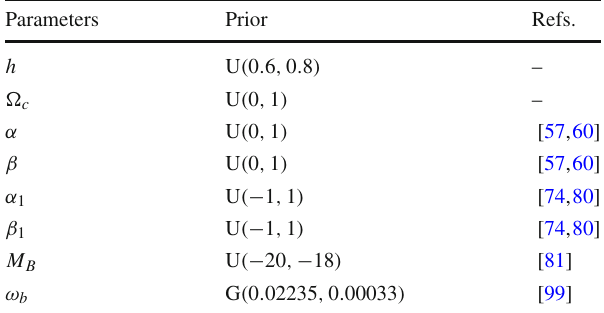
Table 1 Prior probability distributions for the models’ parameters. For a Gaussian (G) prior we inform (μ,σ 2 ) and for a uniform (U) prior